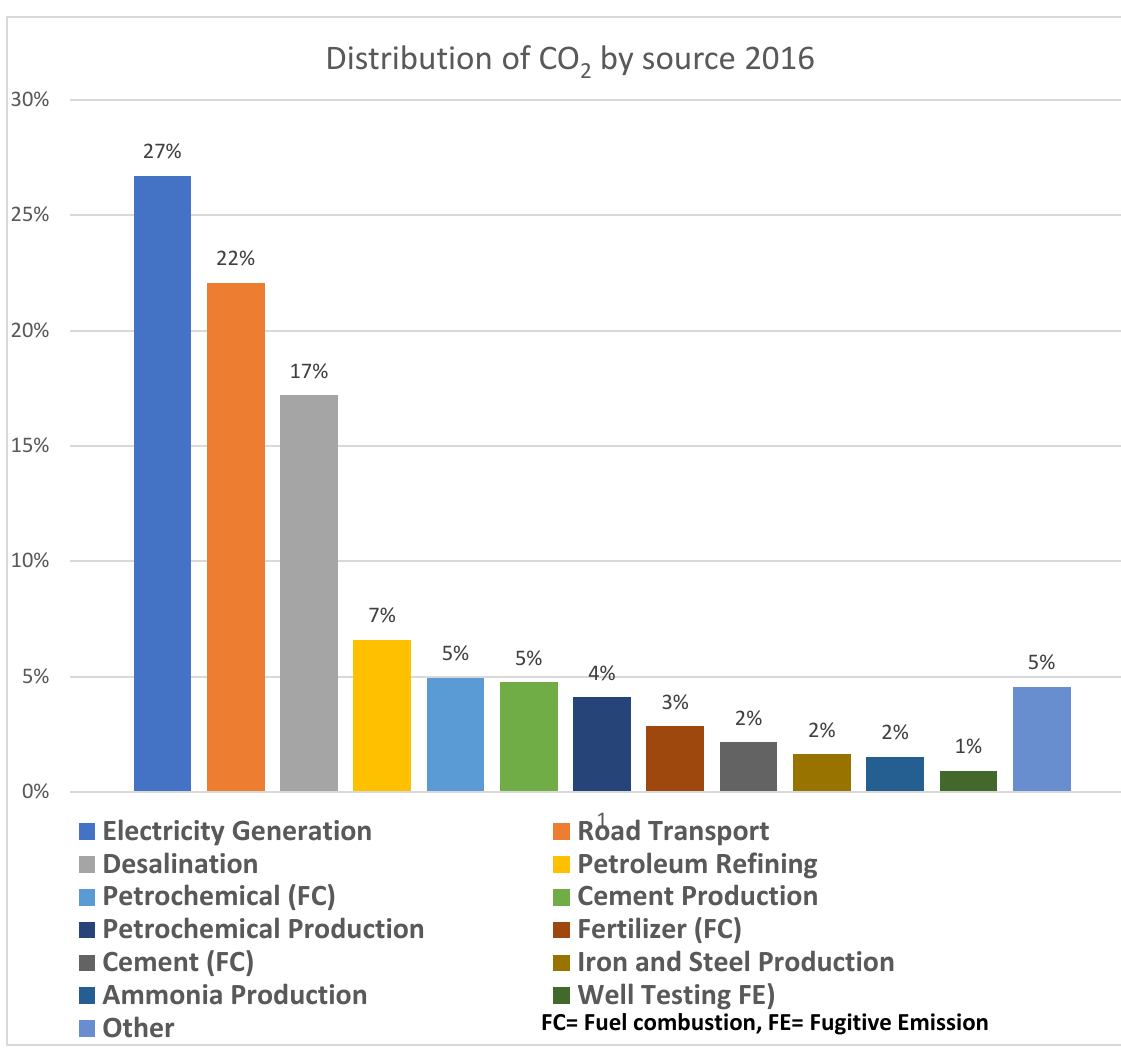
Figure 3. Saudi Arabia’s distribution of CO 2 emissions by source in 2016 [31].